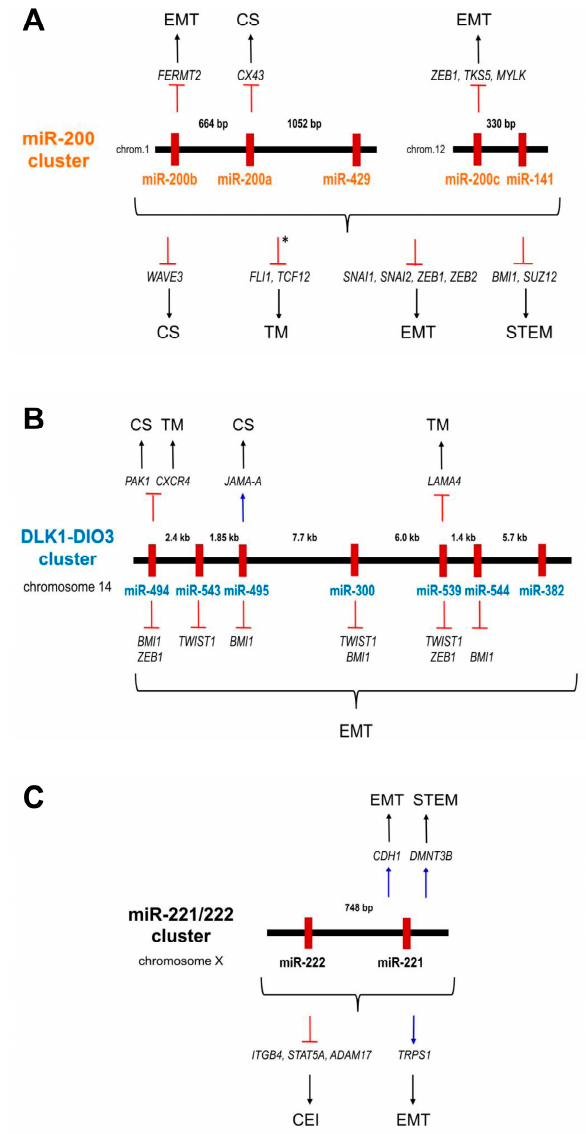
Figure 2. Regulation activities of miRNAs located in miR-200 ( A ), DLK1-DIO3 ( B ), and miR221 / 222 ( C ) clusters. Down- or up-regulation of these miRNAs influences the expression of their target genes which activate the specific events initiating BC invasiveness and stemness. Red T, inhibition of target gene expression; blue arrow, expression of target gene enablement; black arrow, involvement of target genes in specific processes associated with BC invasiveness and stemness. Abbreviations: CS, cytoskeleton structure; CEI, cell-extracellular matrix interactions; TM, tumor micro-environment; EMT, epithelial-to-mesenchymal transition; STEM, cancer cell stemness. Note: *miRs of miR-200 cluster without